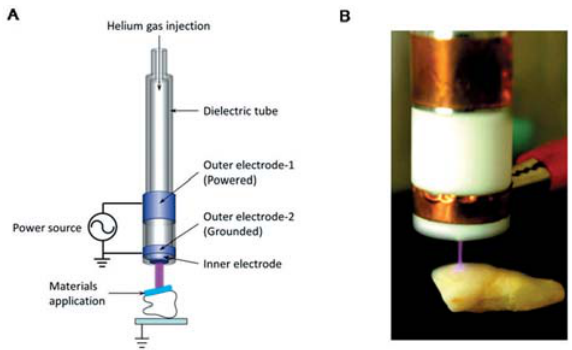
Figure 1- The process of light-activated tooth bleaching using non-thermal atmospheric pressure plasma. (A) (B) photograph of the tooth bleaching